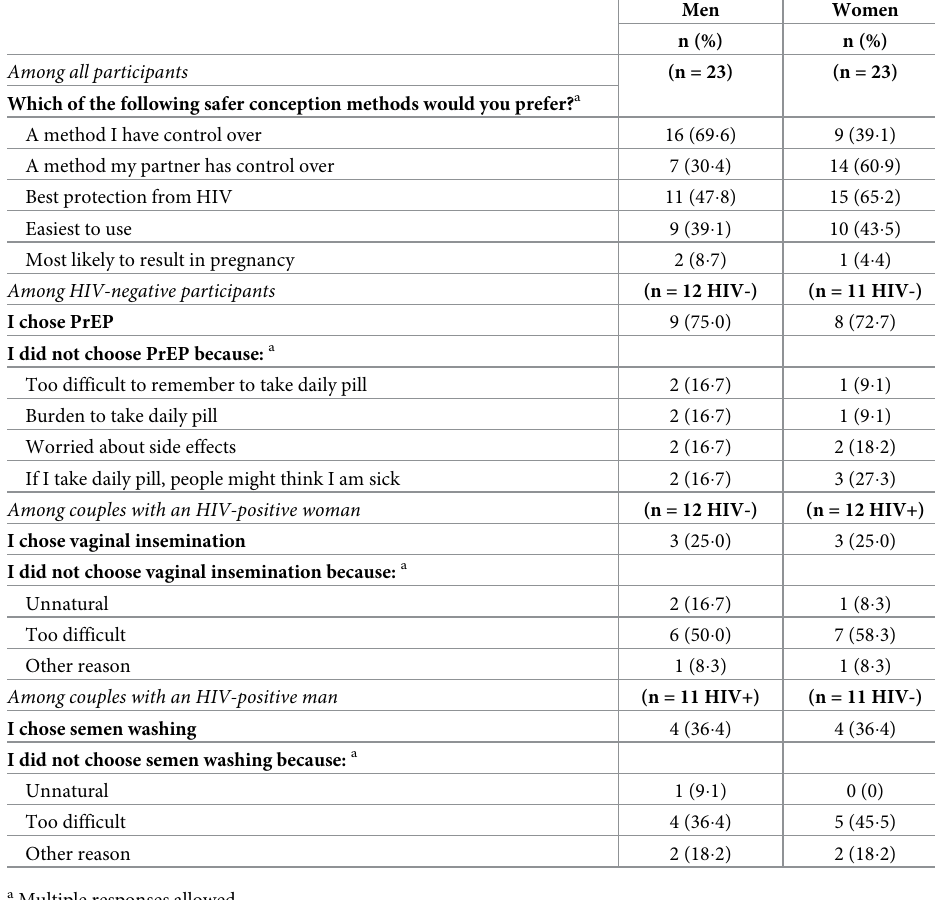
Table 2. Preferences for safer conception methods at enrolment.